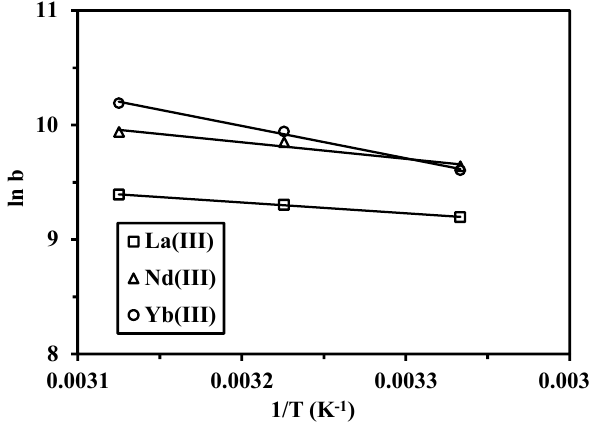
Figure 9. Van’t Hoff plots of ln K L against 1/ T , for sorption of metal (III)